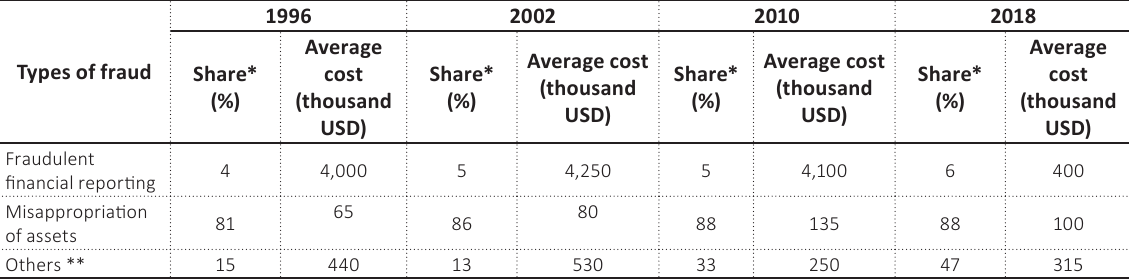
Table 1. The frequency of the two types of fraud and the average losses caused by them in the USA in 1996, 2002, 2010 and 2018